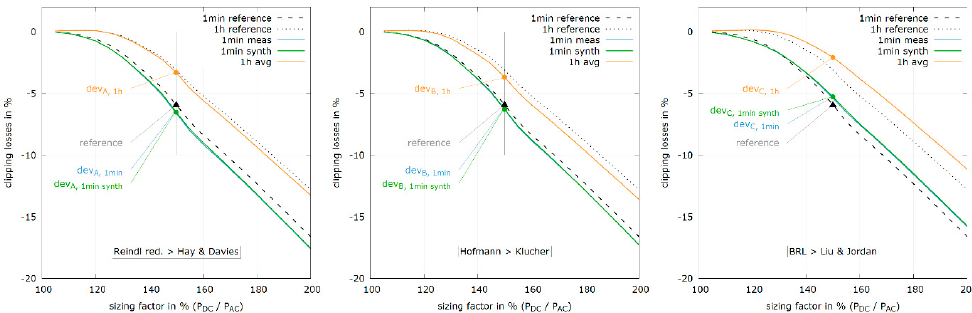
Figure 9. Inverter clipping losses as a function of the sizing factor of the PV plant, for one-minute measurement and synthesized data and one-hour averages. Three different combinations of diffuse fraction and transposition models as example. The clipping losses at 150% sizing factor for all model combinations are displayed in Figure 10.